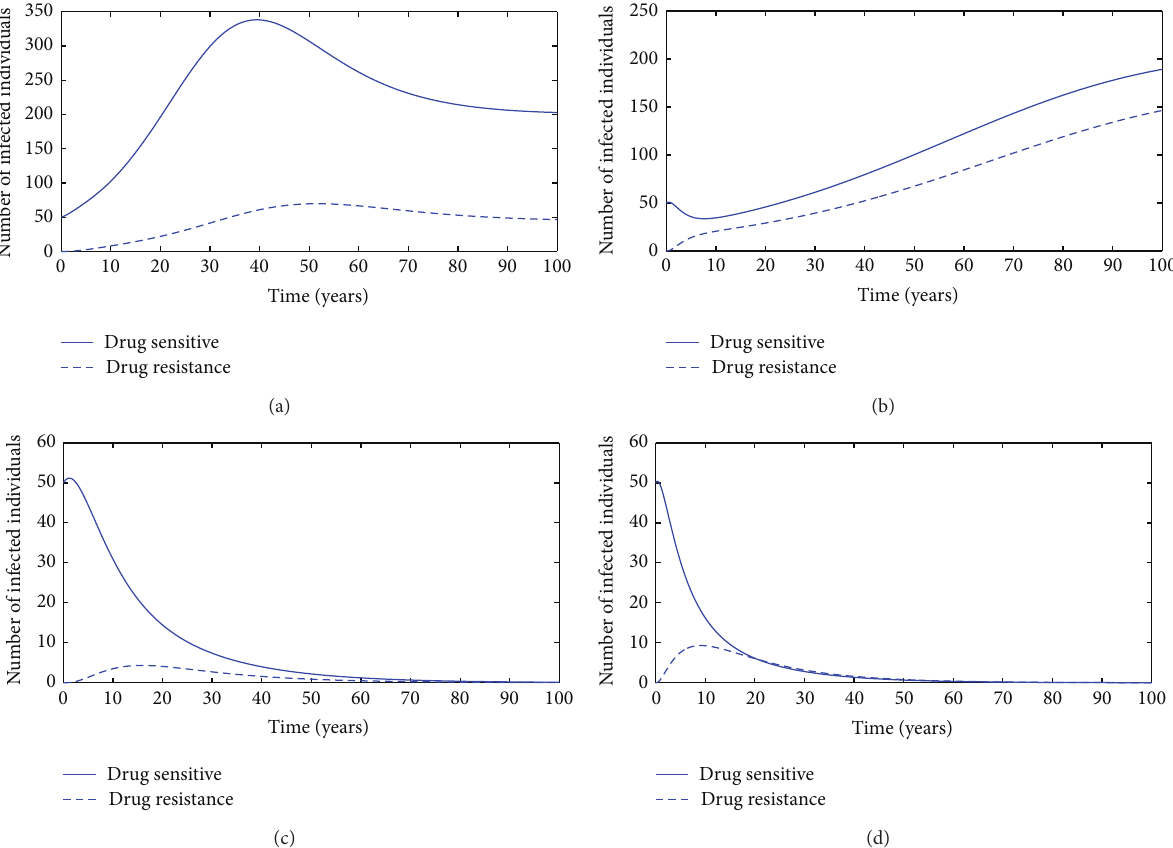
Figure 8: Infected non-drug-resistant (solid curves) and drug-resistant (dashed curves) individuals as a function of time, for the full model. The upper figures are with no education, while the lower figures use education parameters 𝑝 = 0 . 75, 𝜌 𝑒 = 1, and 𝜌 𝑒𝑡 = 1. On the left, treatment parameters considered are 𝜎 𝑡 = 𝜎 𝑒𝑡 = 0 . 125 and 𝜎 𝑘 = 0 . 55, corresponding to average testing and late treatment. On the right, treatment parameters considered are 𝜎 𝑡 = 𝜎 𝑒𝑡 = 4 and 𝜎 𝑘 = 1, corresponding to rapid testing and early treatment. Thus, without education, rapid testing and early treatment are likely to lead to high levels of resistance in the long